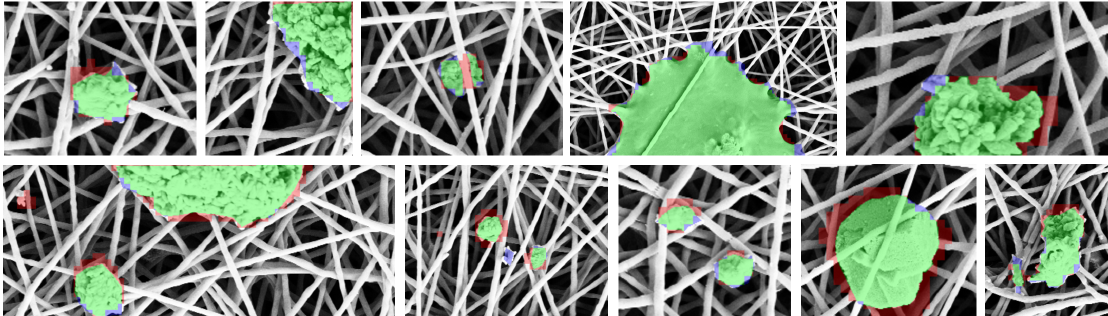
Figure 10. Closeup of the anomalies found by the proposed method. True positives, false positives, and false negatives are showed, respectively, as green,red and blue color. For visualization purposes, the images are slightly cropped and scaled to focus on fine- and coarse-grained